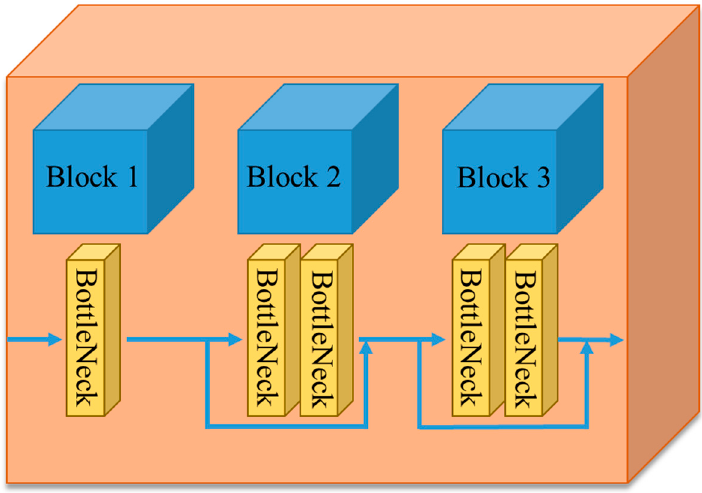
Figure 4. Structure of Convolution Block.